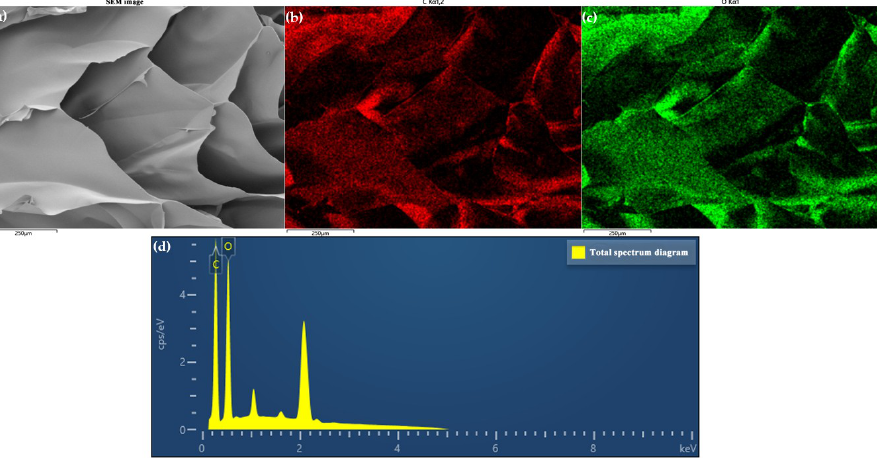
Figure 4. Element mappings of CCNF/ANF-0 sample: ( a ) Selective area image, ( b ) C element, ( c ) O element, and ( d ) total spectral